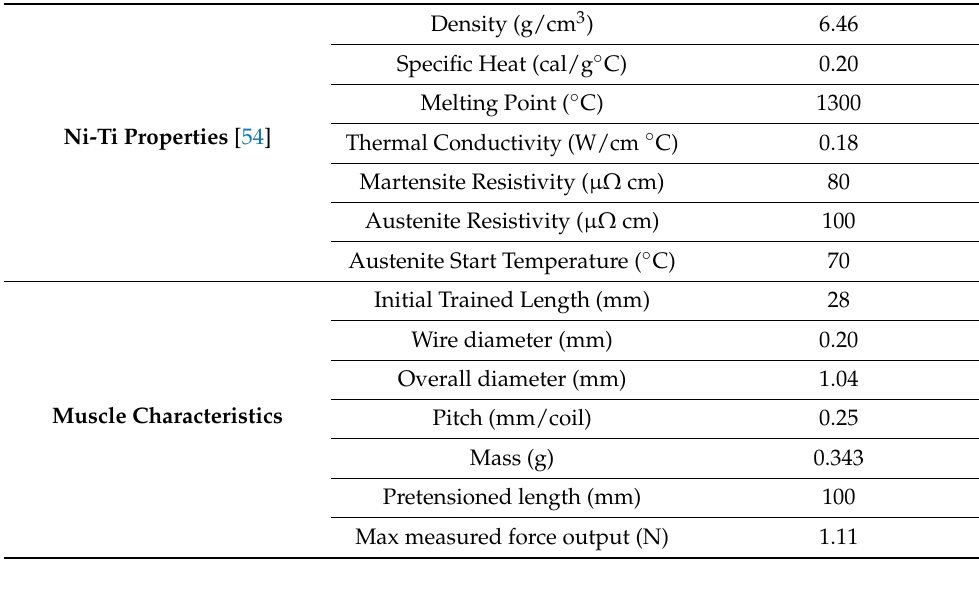
Table 3. Coiled SMA muscle